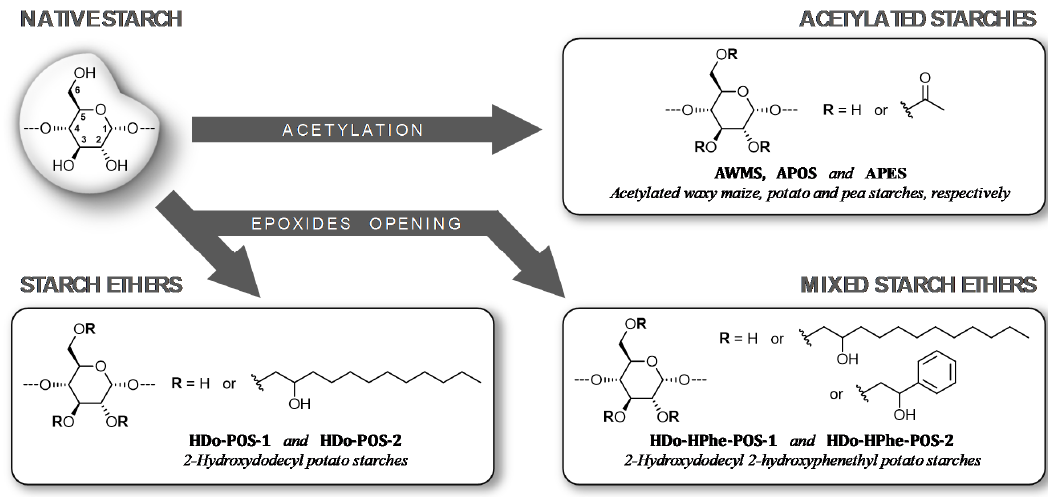
Figure 1. Synthesis, representation and codification of modified starches.